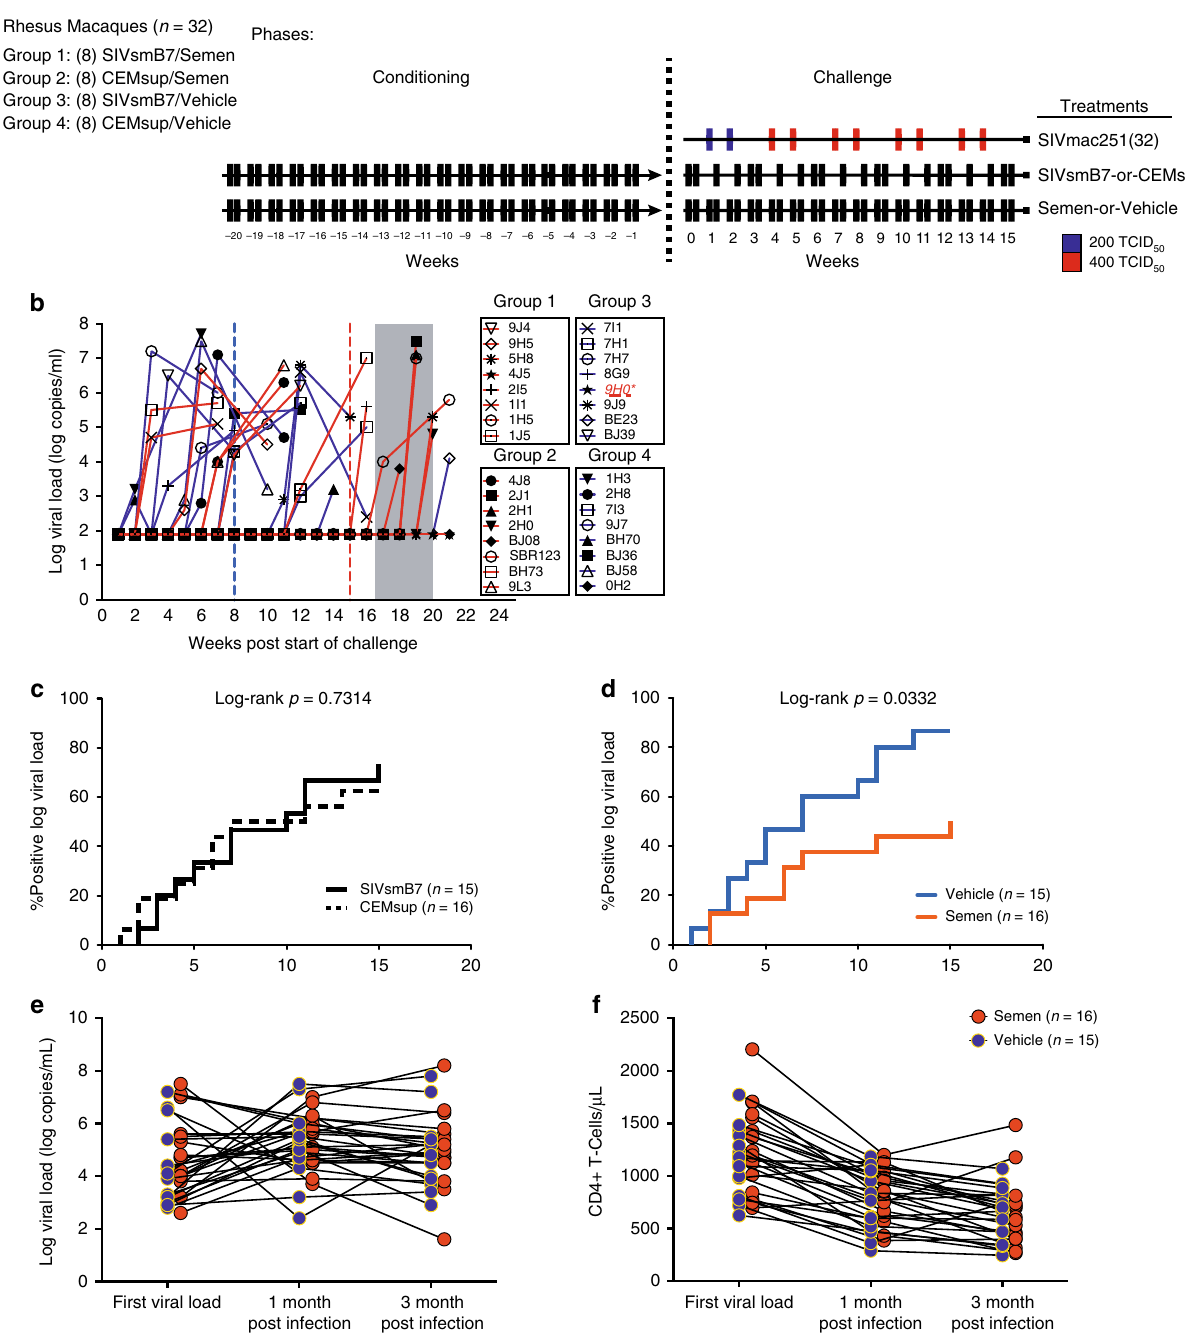
Fig. 1 Intravaginal semen conditioning lowers susceptibility to SIV in rhesus macaques. a 32 Rhesus macaques (Macaca mulatta) were conditioned with intravaginal application of semen and/or SIVsmB7, a replication-incompetent SIV particle for 20 weeks. These animals were then challenged with low-dose SIVmac251 (200 – 400 TCID50) for 16 weeks intravaginally. b Log viral load line graphs for all 32 animals in the study with grouping listed. Blue vertical dashed line indicates time-point for 50% infection for non-semen condition groups and red vertical dashed line indicates 50% infection for semen conditioned group. c Survival curve comparing SIVsmB7 conditioned vs. animals receiving CEM sup [Log-rank p = 0.7314]. d Survival curve comparing semen and vehicle-conditioned animals [Log-rank p = 0,0332]. 1- and 3-month post-acquisition VL ( e ) and CD4 ( f ) were similar in semen and